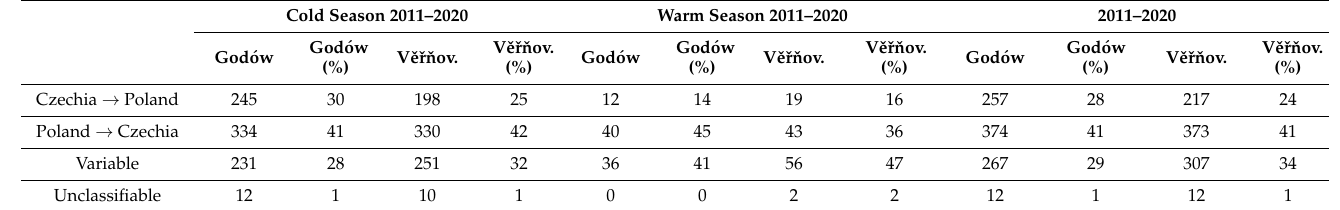
Table 3. Quantification of transboundary PM 10 transmission between the Czech Republic and Poland (number of exceedances of the value of 50 µ g · m − 3 for average daily PM 10 concentrations), 2011–2020.